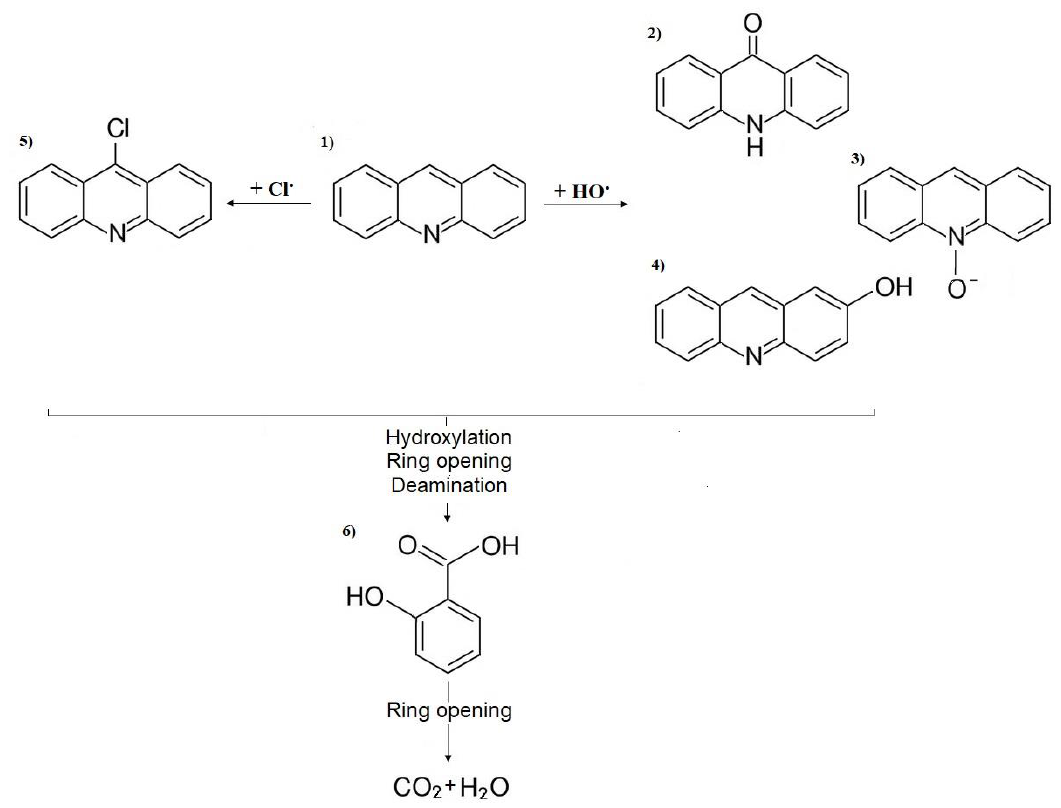
Figure7. Possibledecompositionof( 1 )ACRwiththeidentifiedintermediates, ( 2 )Acridone, ( 3 )Acridine- Figure 7. Possible decomposition of ( 1 ) ACR with the identified intermediates, ( 2 ) Acridone, ( 3 ) 10-oxide, ( 4 ) 2-Hydroxyacridine, ( 5 ) 9-Chloroacridine, and ( 6 ) Salicylic Acridine-10-oxide, ( 4 ) 2-Hydroxyacridine, ( 5 ) 9-Chloroacridine, and ( 6 ) Salicylic acid.